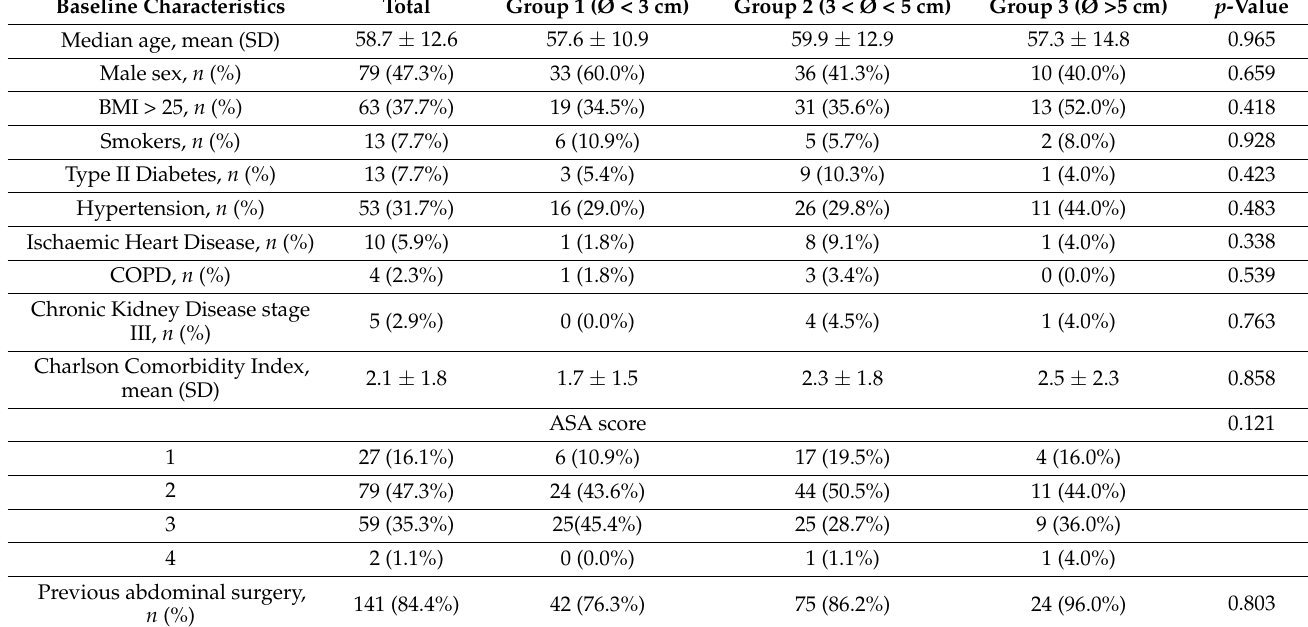
Table 1. Baseline characteristics.